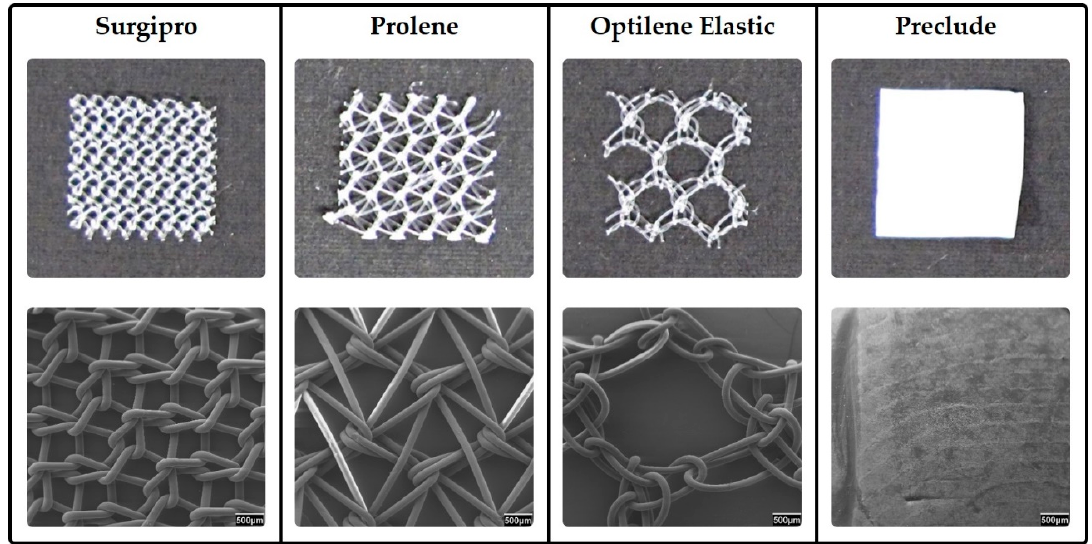
Figure 2. Permanent synthetic meshes. Reticular PP meshes with different pore sizes (Surgipro TM , Prolene® and Optilene® Elastic) and the laminar expanded polytetrafluorethylene (ePTFE) mesh (Preclude®) are shown. Macroscopic appearance is shown in the upper images. Scanning electron micrographs show a magnified view of the meshes structure in the lower images (20x magnification).